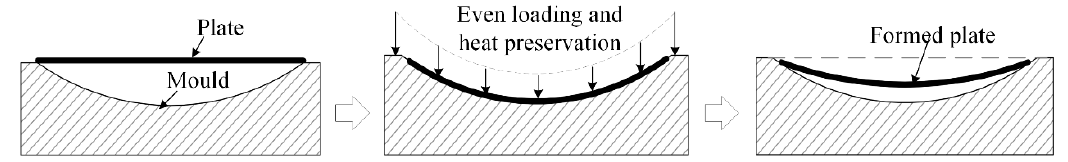
Figure 1. The process of creep age forming.